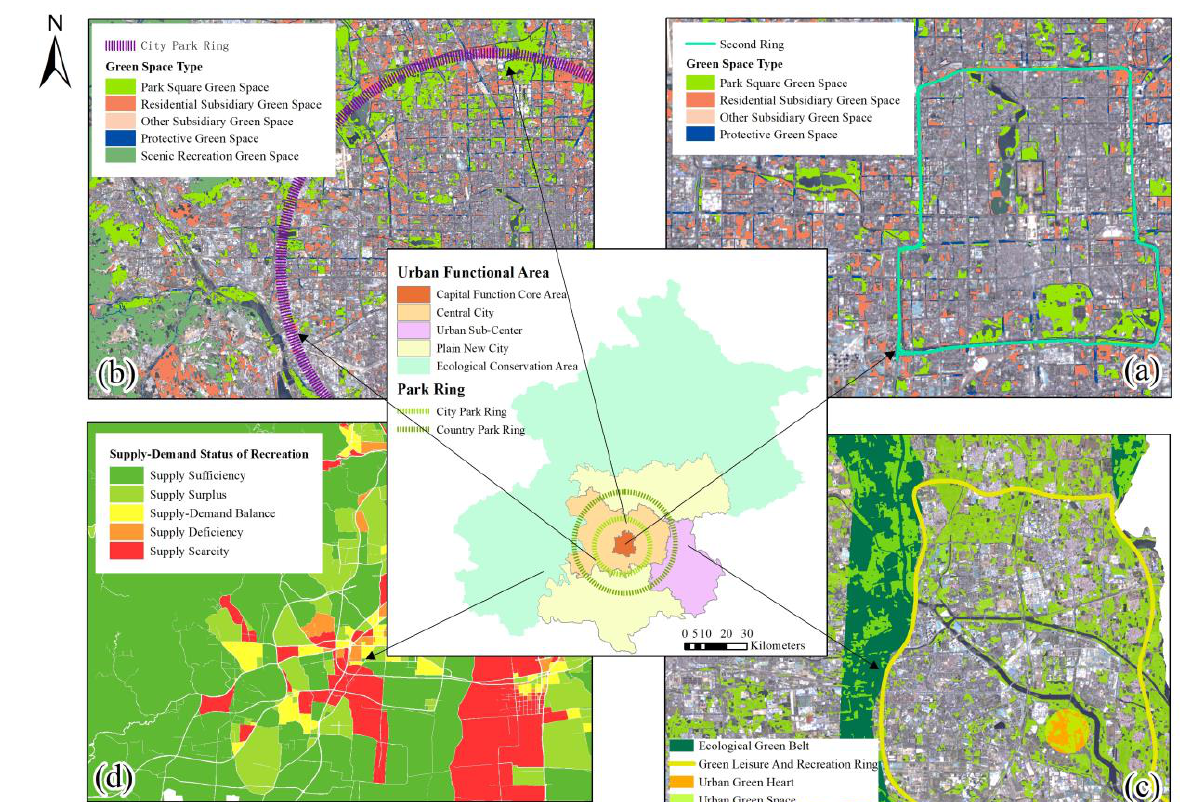
Figure 11. Typical areas in construction of UGS: the capital functional core area (a), partial region of the central city and the urban park ring (b), partial region of the urban sub-center (c), partial region of ecological conservation area (d).